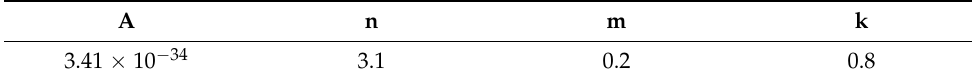
Figure 11. Experimental vs. numerical displacements at ϕ 0 °. 0 0.002